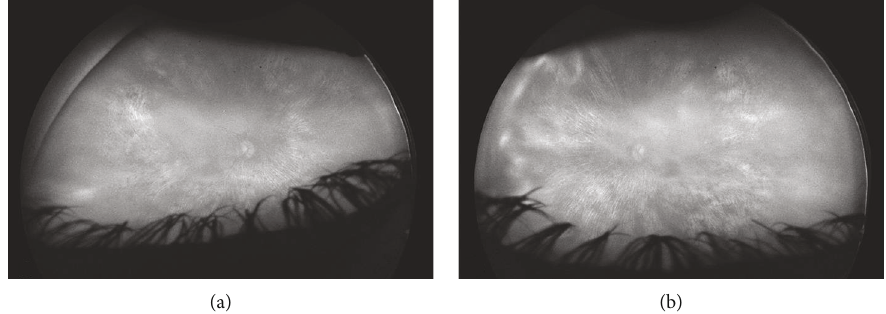
Figure 2: Fundus auto fl uorescence photos of the (a) right eye and the (b) left eye. Pale fundi and absence of RPE auto fl uorescence. Chorioretinal atrophy reveals the hyperauto fl uorescent attributes of the